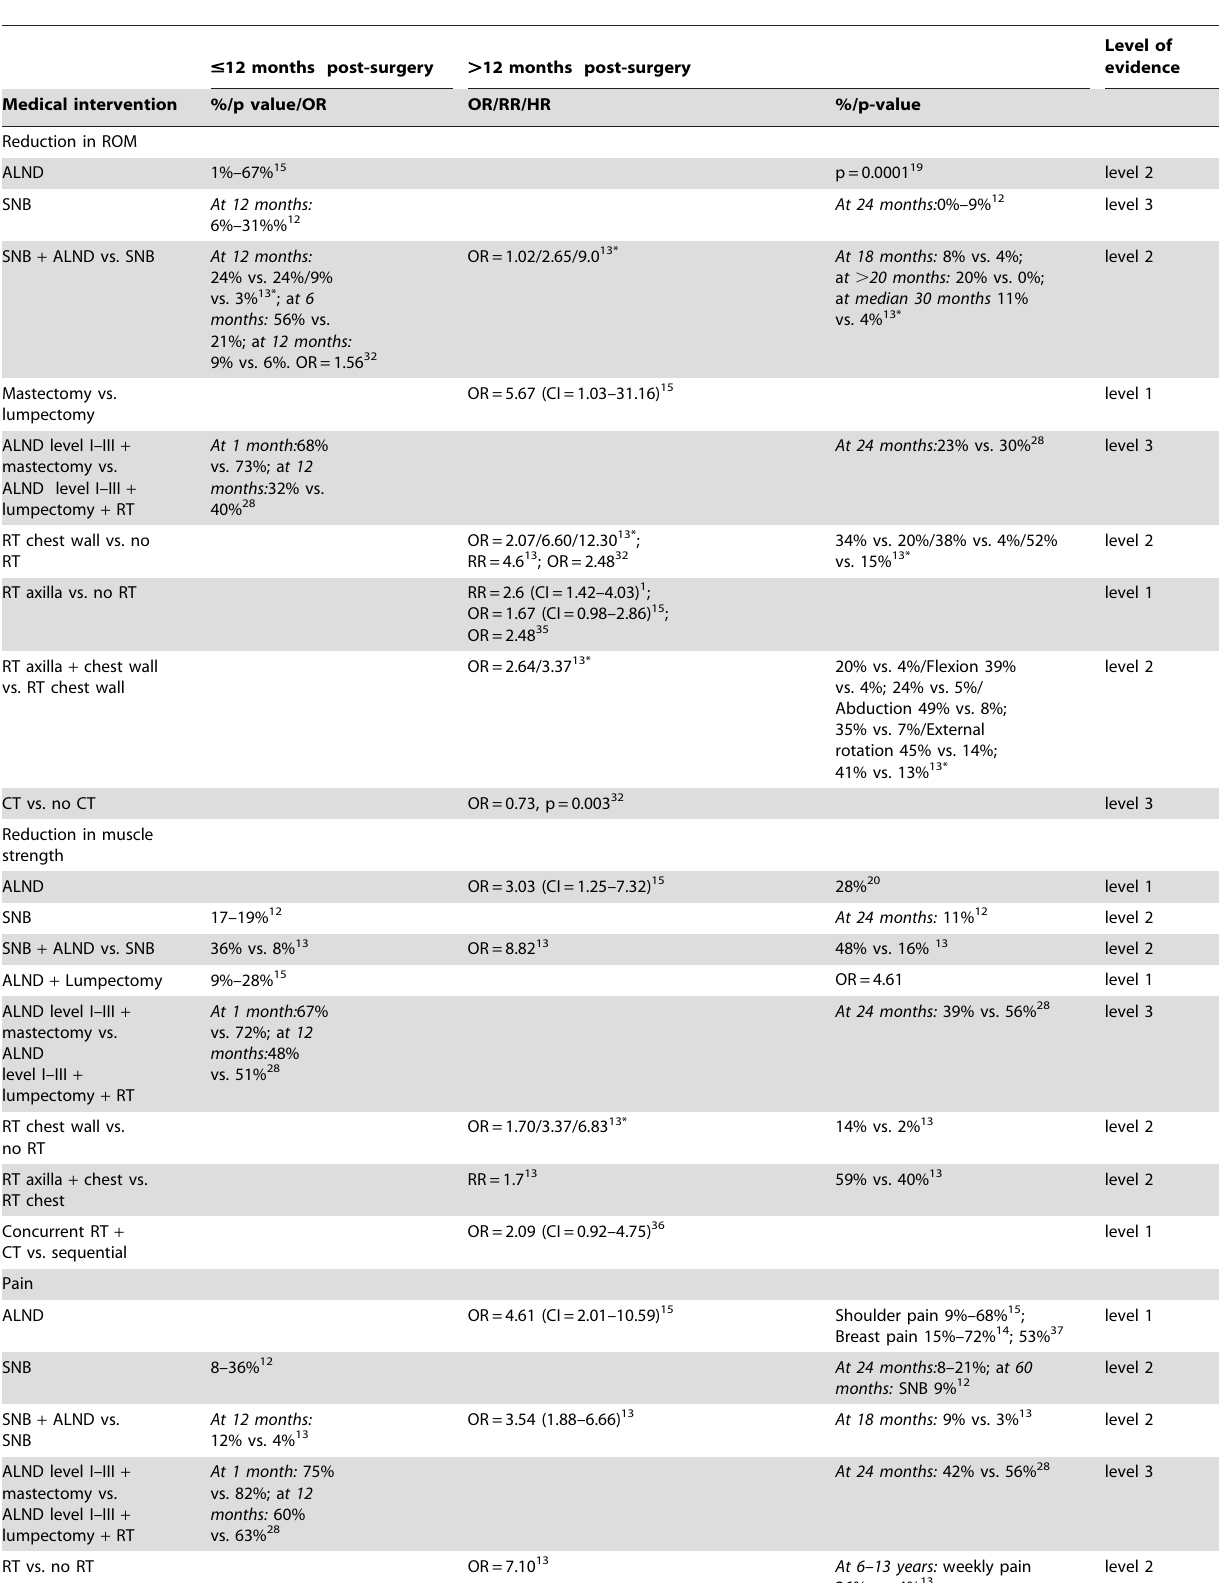
Table 6. Adverse treatment effects in relation to impairments in upper extremities and